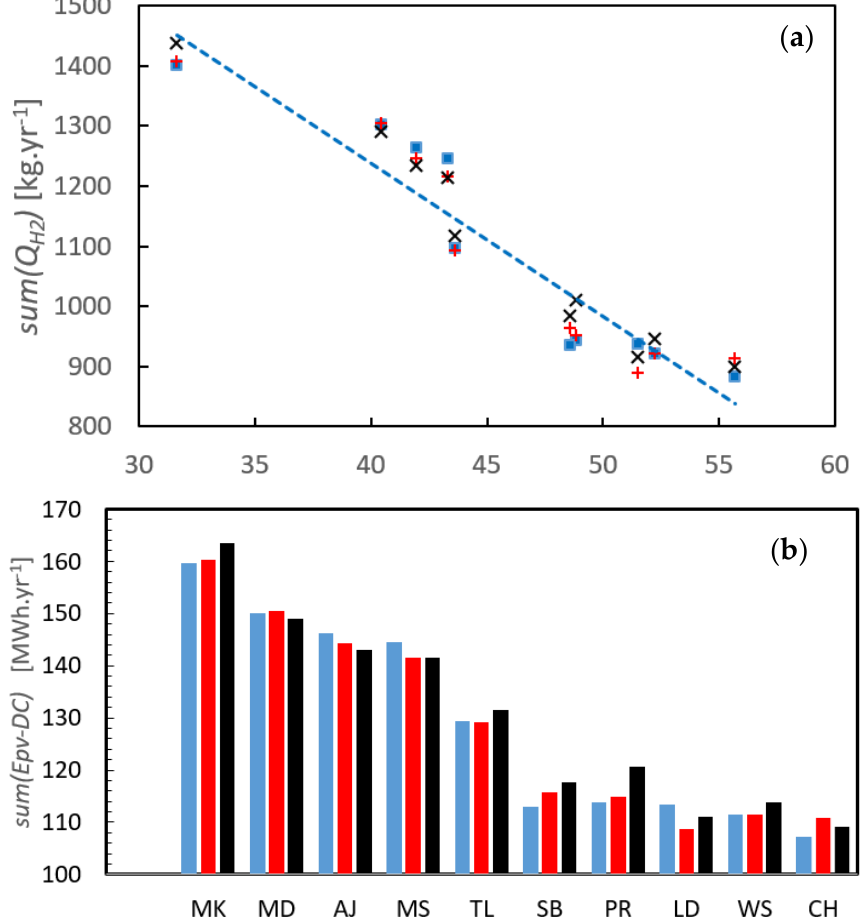
Figure 3. ( a ) Latitude impacts on the H 2(g) capacities (kg · yr − 1 ). ( b ) Yearly PV cumulative energy (MWh · yr − 1 ) for a 100 kW p PV plant. Histograms and Marks: blue square: year 2005 (historical); “+” (red): year 2020 (RCP 2.6, favorable, see Section 3.3.2); “ × ” (black): year 2020 (RCP 8.5, unfavorable, see Section 3.3.2). Blue line: linear regression on year 2005 for historical data.